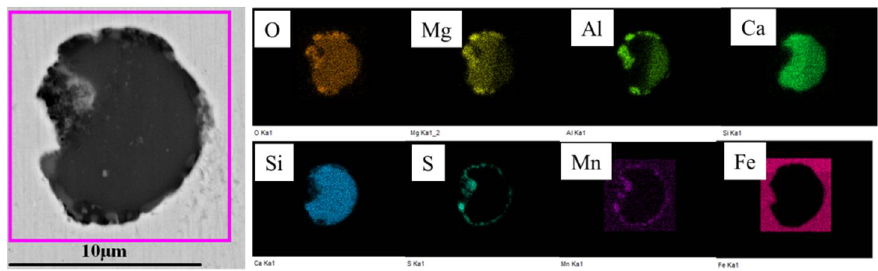
Figure 16. Morphology and composition of typical inclusions in billet.